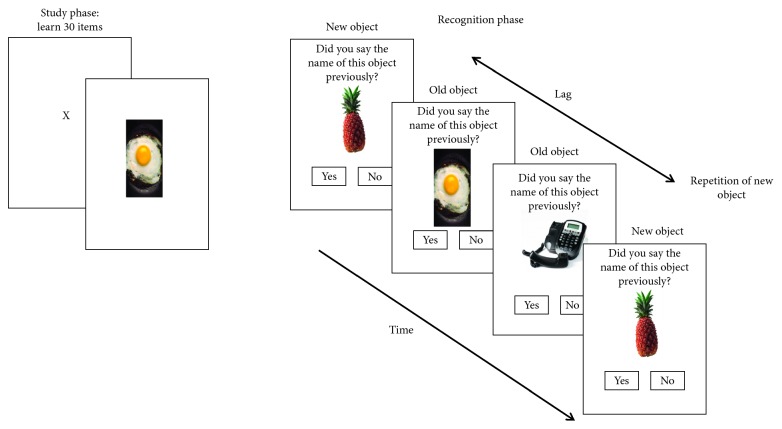
Recollection task.